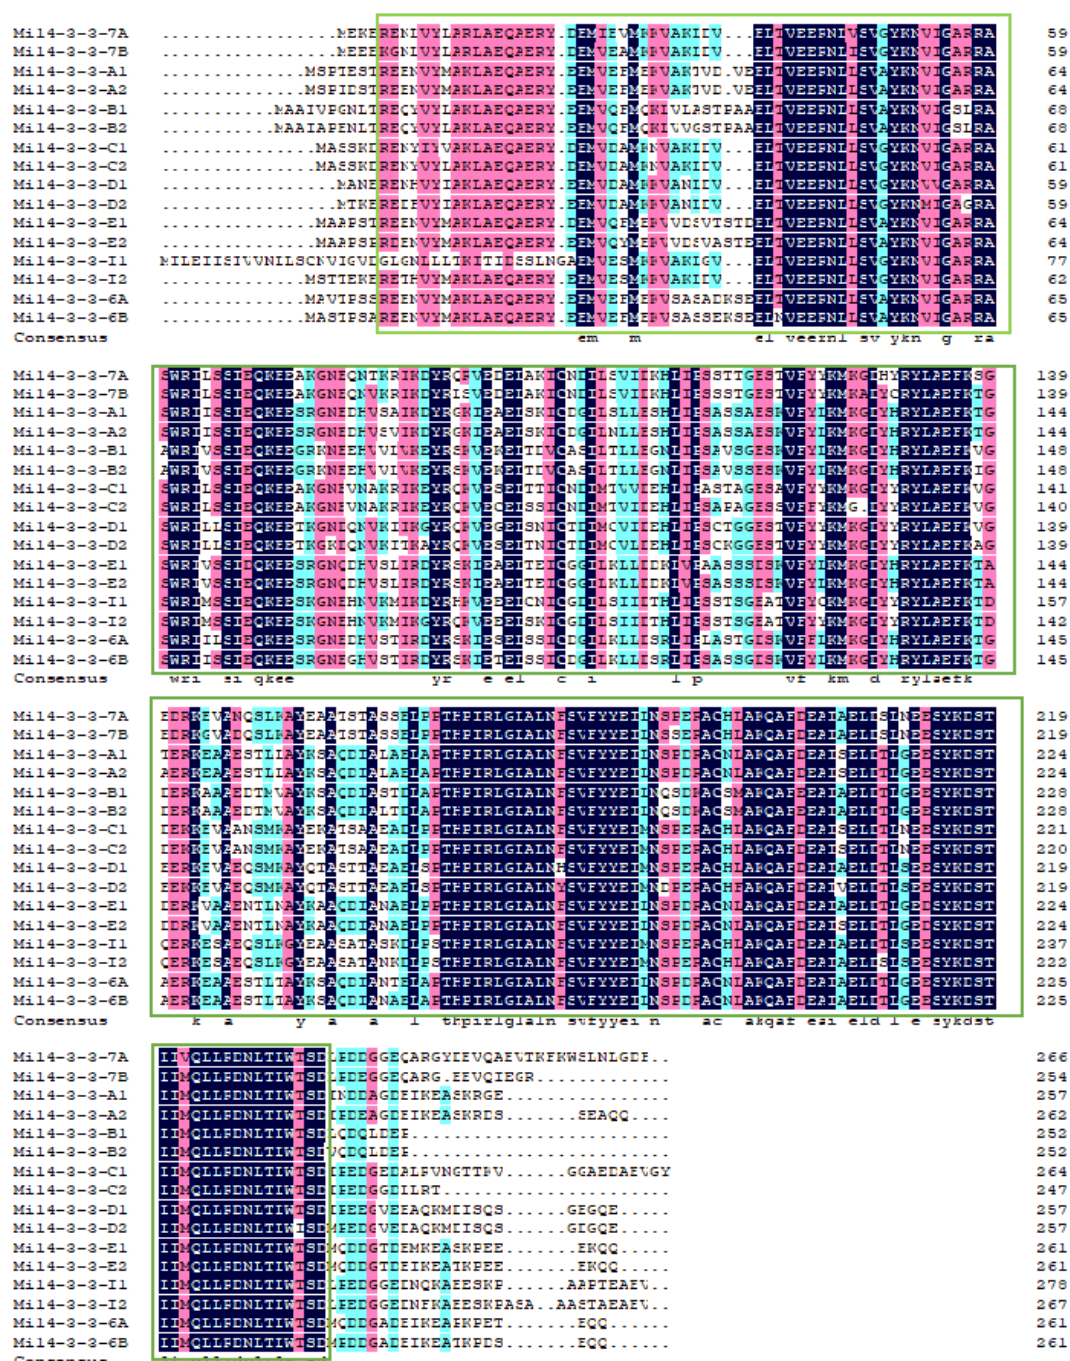
Figure 2. Multiple sequence alignment of all 14-3-3 proteins in mango. The typical conserved PFAM00244 domain is marked by a green box.